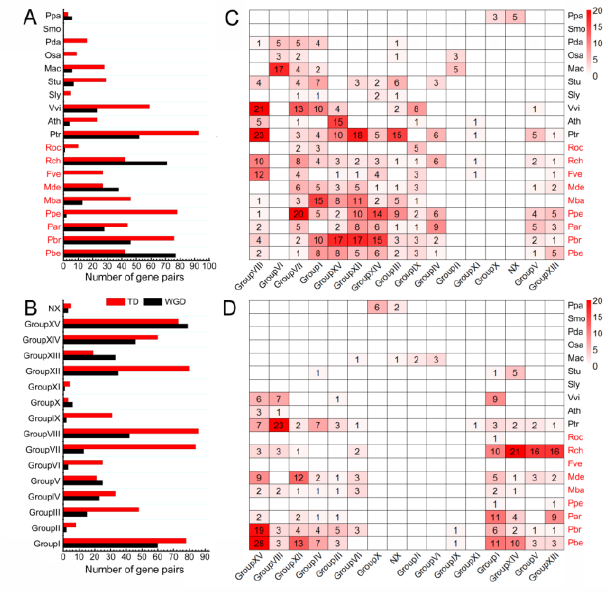
Figure 3. Global and exact expansion rates for each subfamily from 19 species. The value of each group was calculated by the member size divided by the number of ancestral genes.